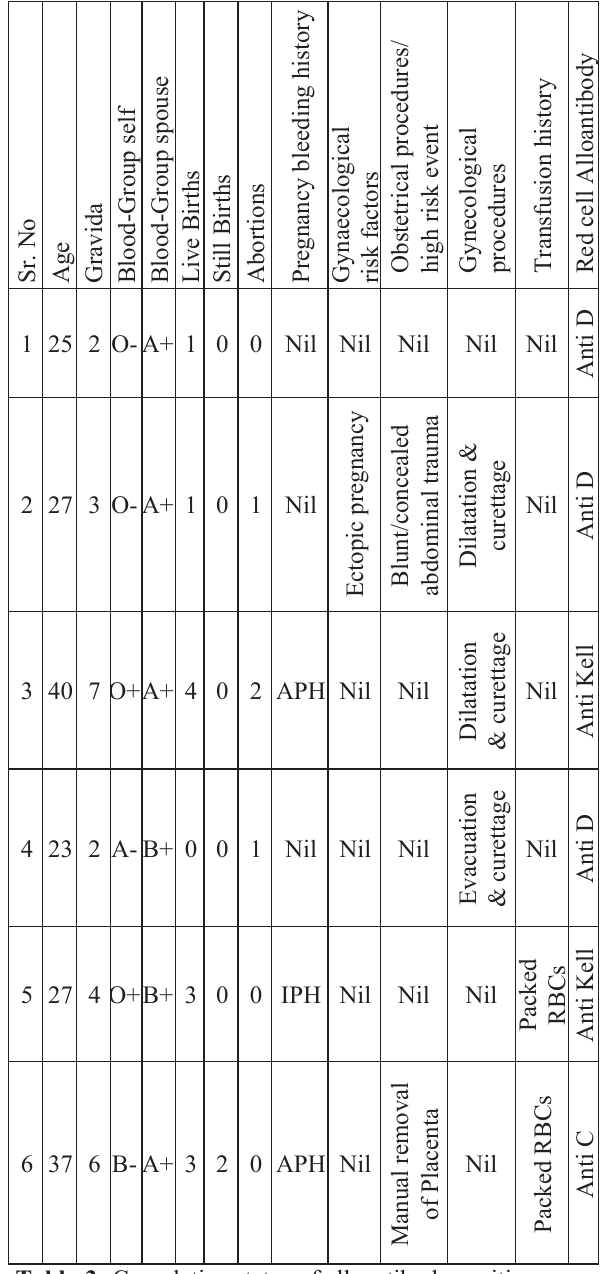
Table-3: Cumulative status of alloantibody positive